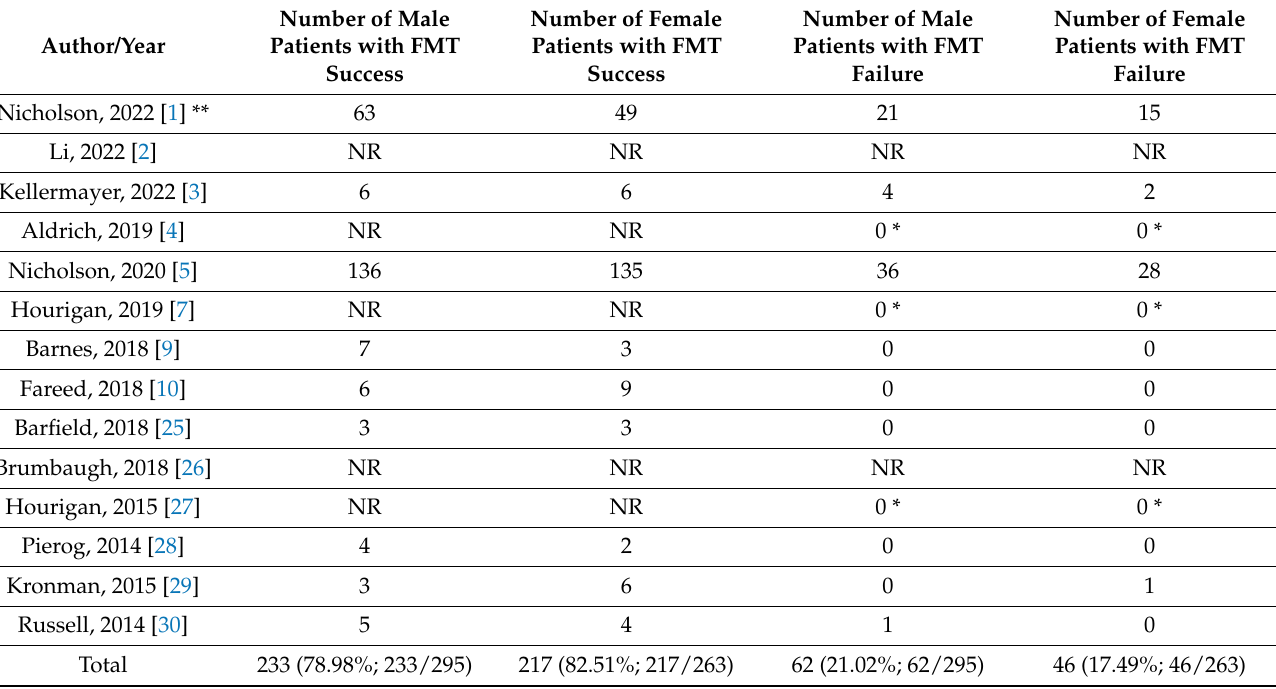
Table 5. Efficacy outcomes by gender.